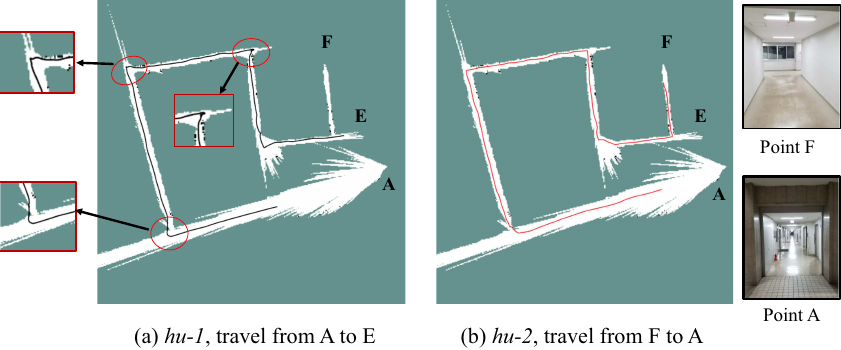
Figure 13. Estimated trajectories on the manually collected dataset. The red circles highlight the distorted parts caused by the accumulated error. Snapshots at point A and F are shown at the right